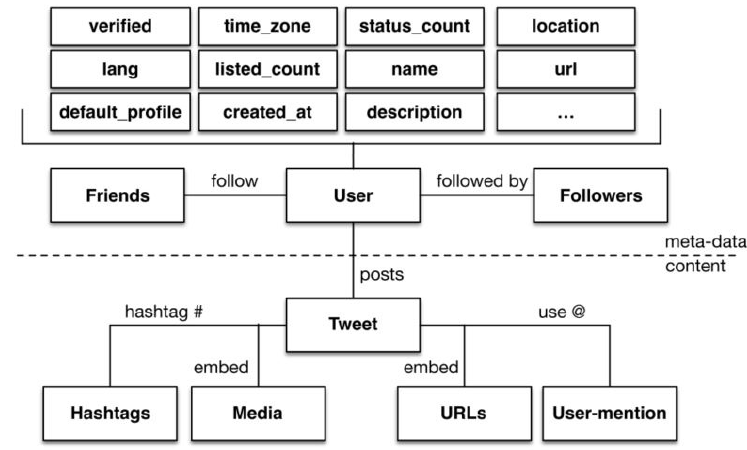
Figure 2. Twitter infographic (adapted from [40]).